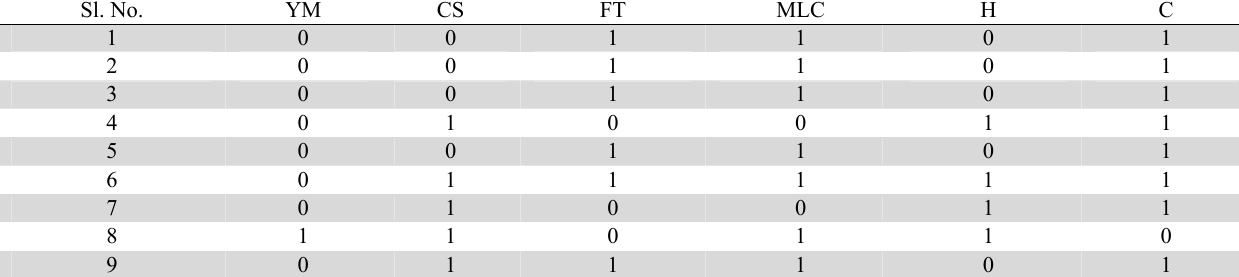
Incidence matrix ( B 3 ) at slicing parameter θ 3 = 0.30 for example 4 Sl. No.